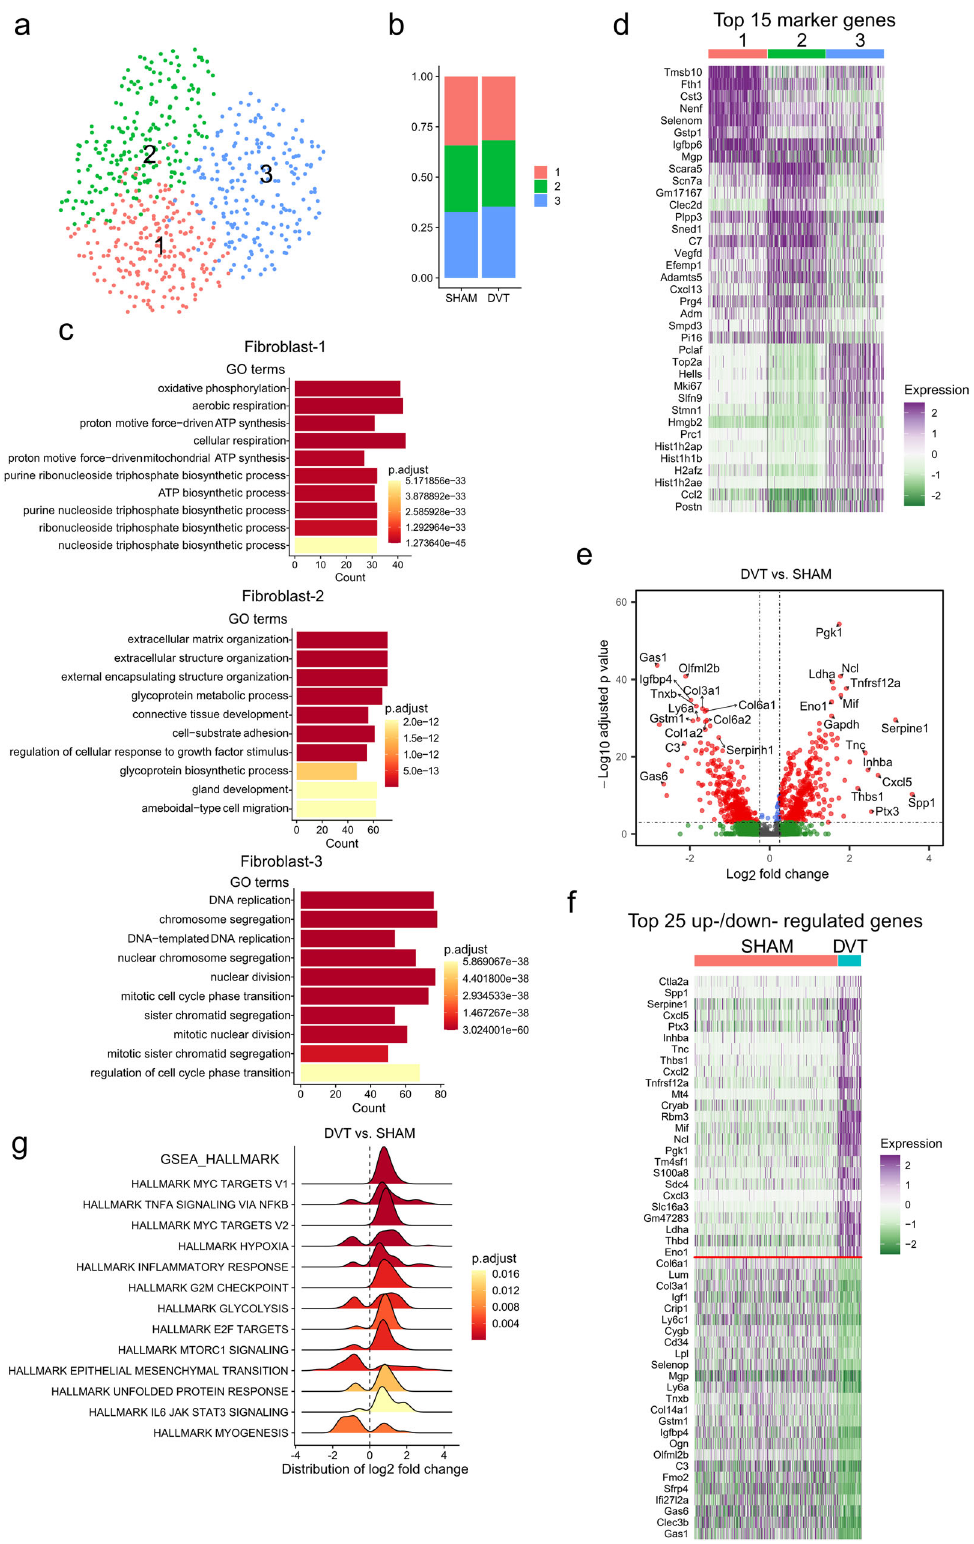
Fig. 3 Gene expression heterogeneity of fi broblasts. a UMAP plot of sub-populations in fi broblasts of sham and DVT data combined. b Relative distribution of sub-populations in sham and DVT groups. c GO analysis of each fi broblast sub-population in comparison to the other two sub-populations. d Heatmap of the top 15 enriched genes in each fi broblast subpopulation in comparison to the other two sub-populations. e Volcano plot of DEGs in total fi broblasts (DVT vs sham group). f Heatmap of the top 25 up- and downregulated genes in DVT compared to sham group. Up- and downregulated genes were separate by a red line. g GSEA of the altered gene sets in DVT versus sham